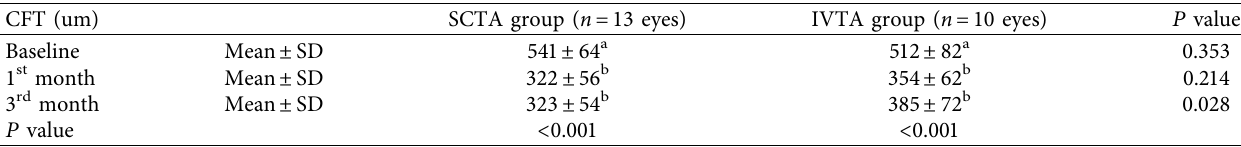
Figure 1: BCVA in both groups at baseline, one month, and three months. Table 3: Central foveal thickness in both groups at baseline, 1, and 3 months.